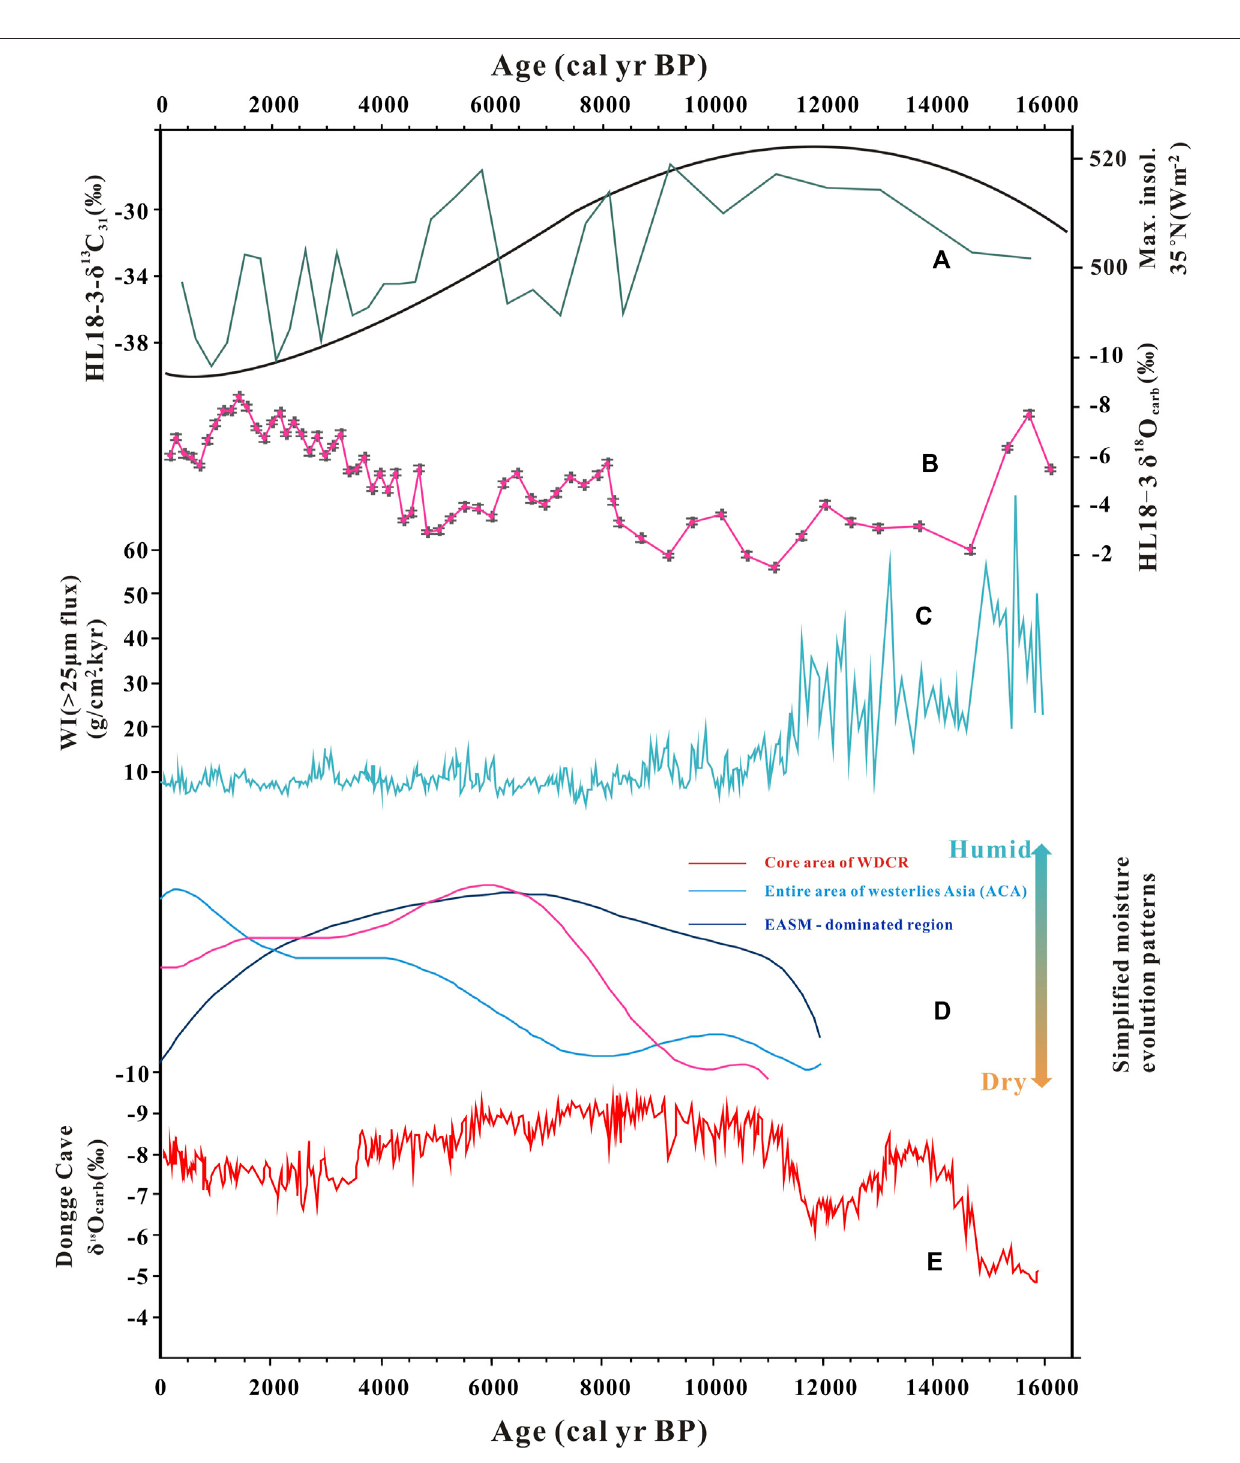
FIGURE 8 | Coordination of the role between EASM and Westerly in the Hurleg lake. (A) The δ 13 C 31 in the HL18-3 core (light green), max insolation of 35 ° N (black line, Laskar et al., 2004). (B) The δ 18 O carB in the HL18-3 core. (C) Lake Qinghai Westerlies climate index (WI, fl ux of > 25 mm fraction) (An et al., 2012). (D) Simpli fi ed moisture evolution patterns in different regions of Asia during the Holocene (Chen et al., 2019). (E) Stalagmite calcite δ 18 O from Dongge Cave (Dykoski et al., 2005).